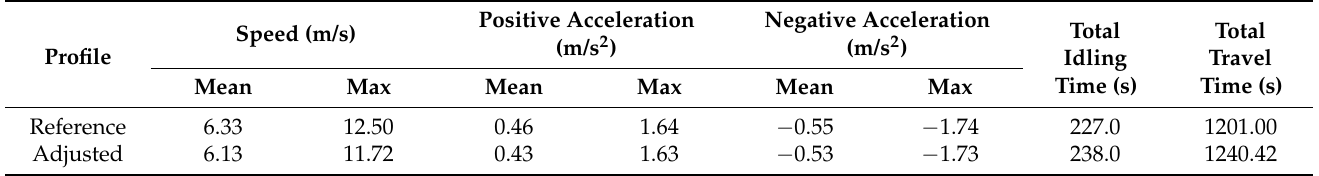
Table 13. Kinetic summary statistics under reference and adjusted speed profiles for the Lisbon case with reversed road profile.